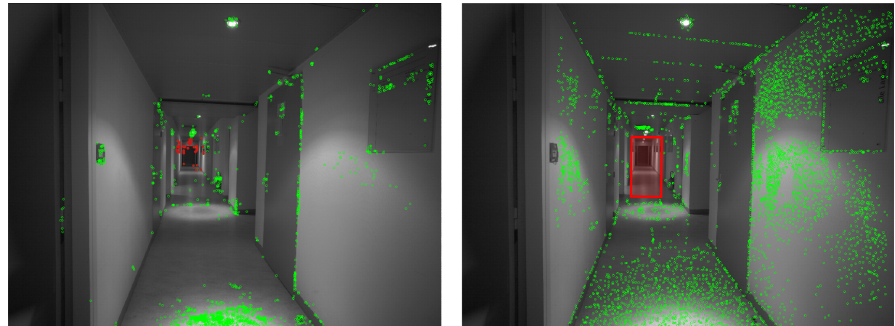
Figure 20. Comparison of the tie-points distribution. These are tie-points between one image with all others images in the dataset. ( Left ): Classical method by SIFT, ( Right ): SIROP . Tie-points distribution with SIROP is better. Tie-points in the “far” scene part (the red frame in right image and the red points in left image) with low ground resolution is ignored by SIROP .